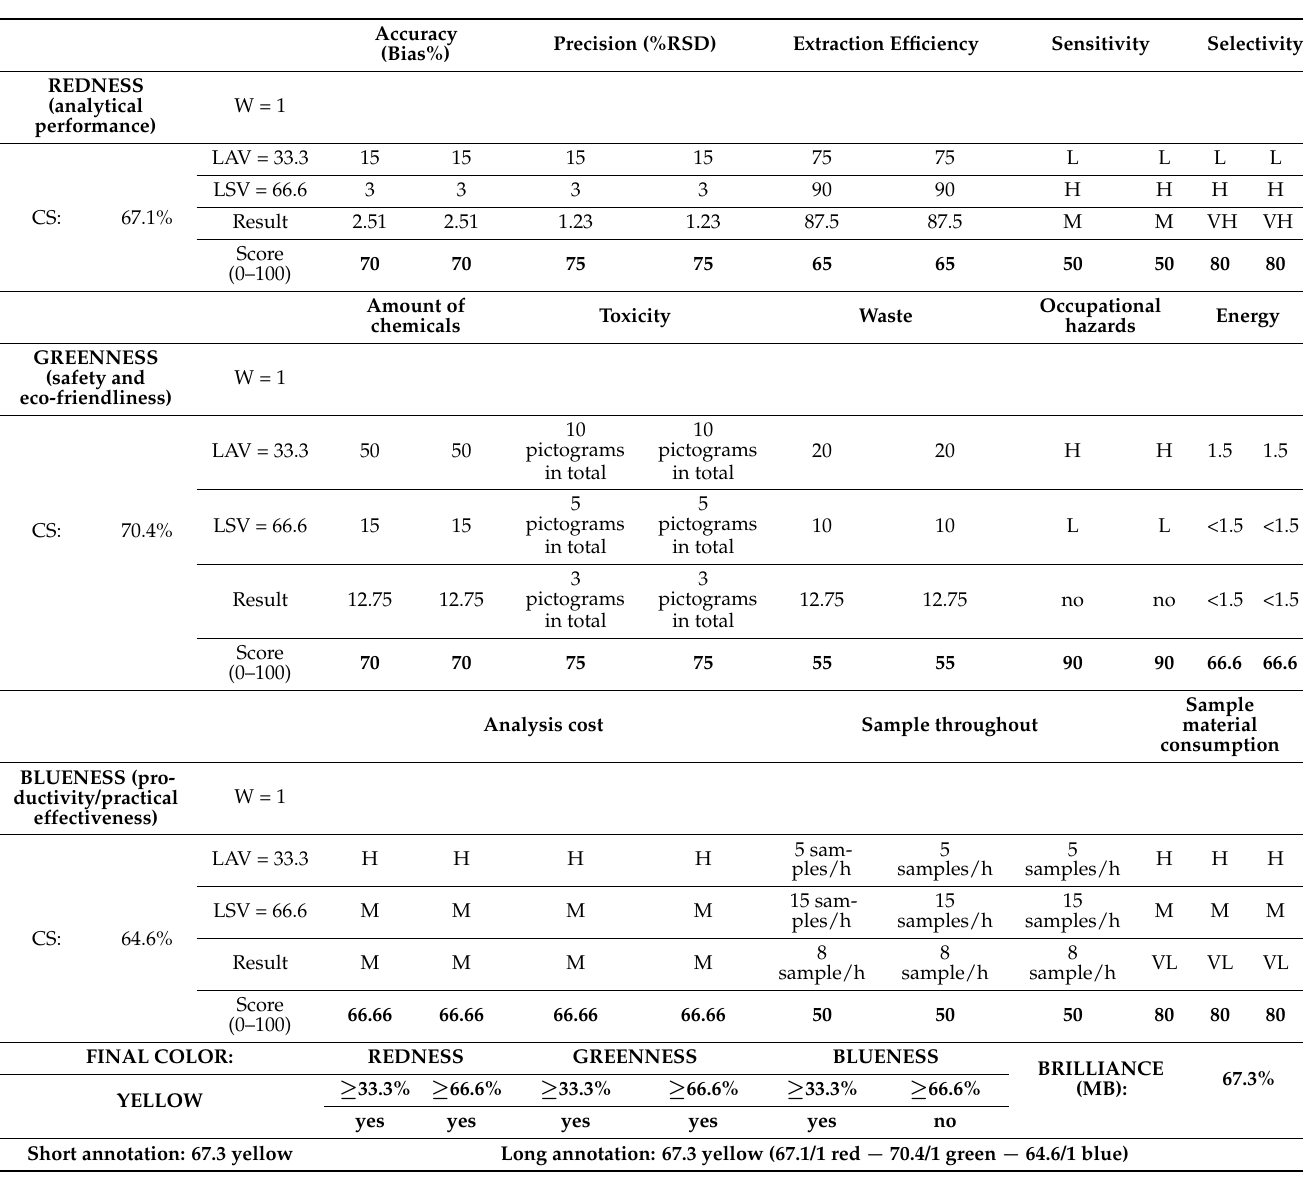
Table 6. Evaluation of the developed HPLC method using RBG additive color